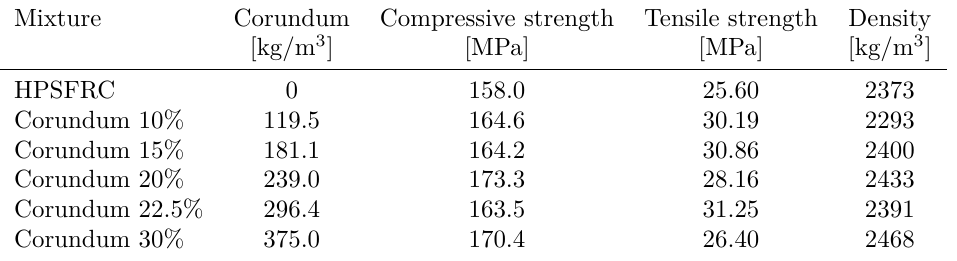
Table 3. Mechanical properties of high-performance concrete with corundum.